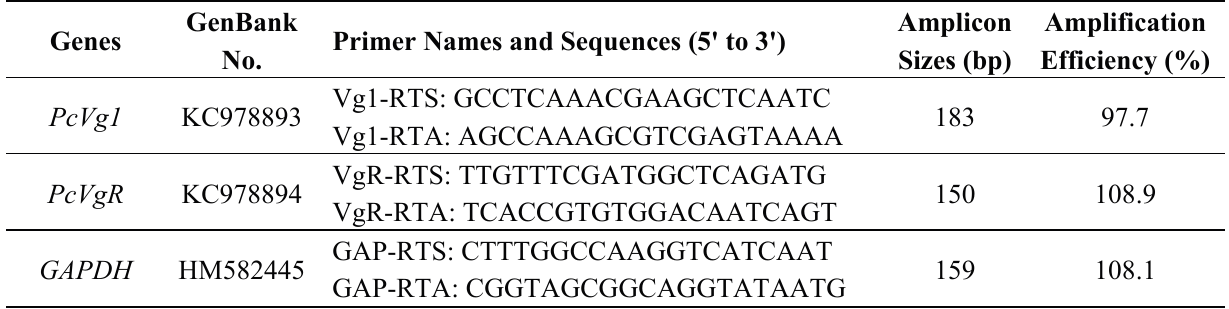
Table 2. Primers used for